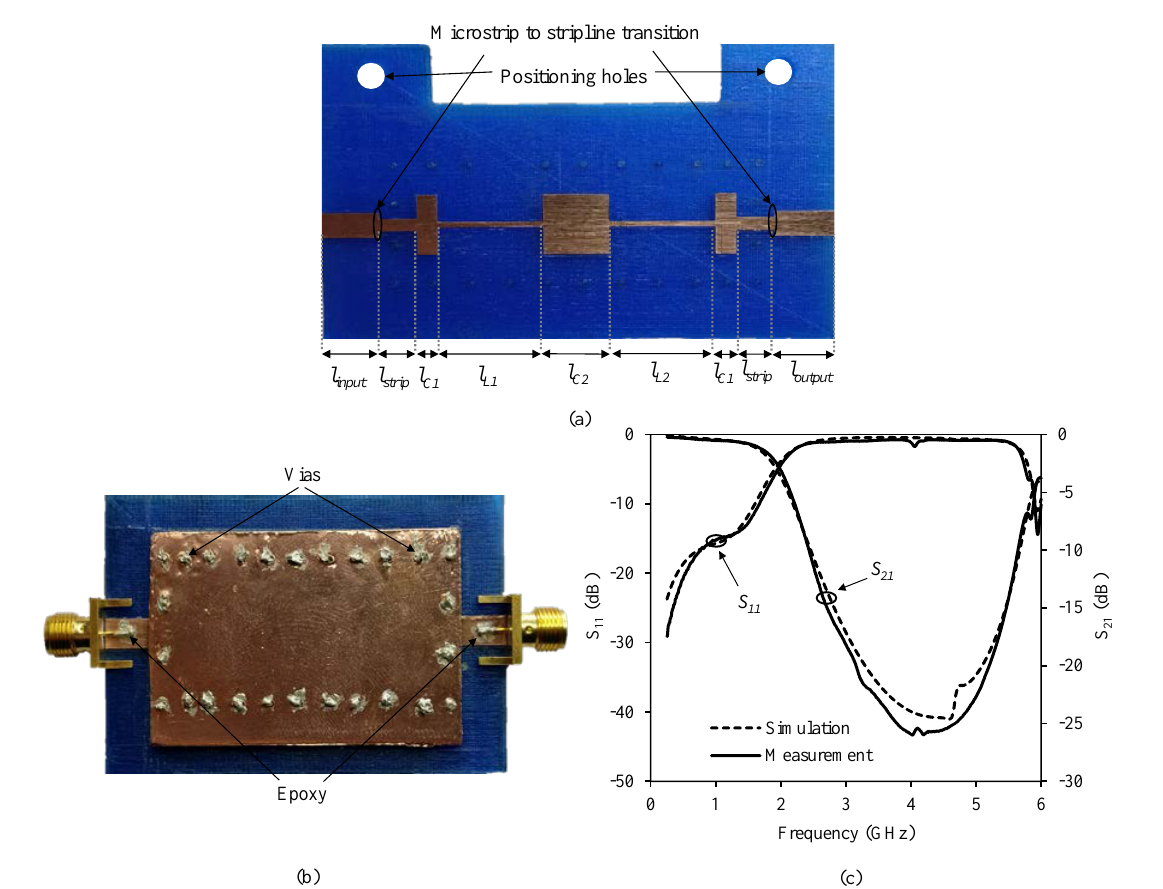
Figure 13. ( a ) Stripline stepped impedance filter with 100% density before completing its implementation. ( b ) Photograph of the fabricated filter. ( c ) Measured and simulated response of the stripline stepped impedance filter with a 100% density substrate.